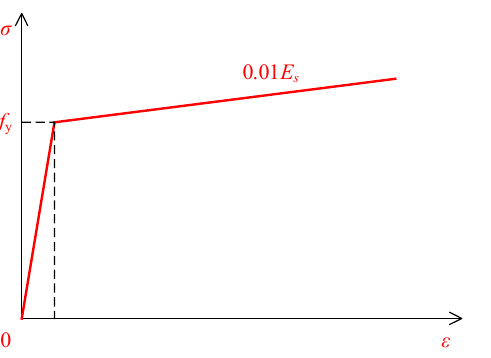
Figure 5. Material model of steel. (Adapted with permission from Ref. [22]. Copyright 2022 Springer Nature.)